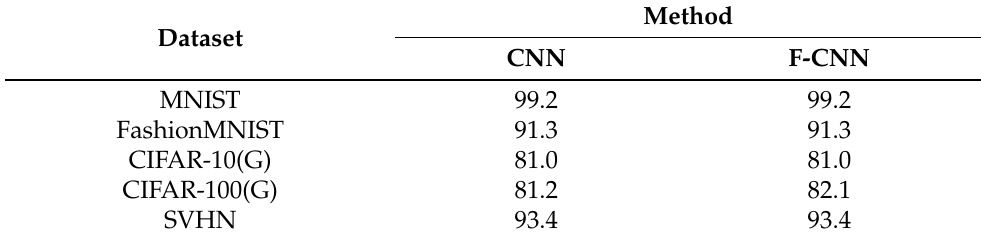
Table 5. Accuracy (%) of VGG-13 on gray-scale image datasets.